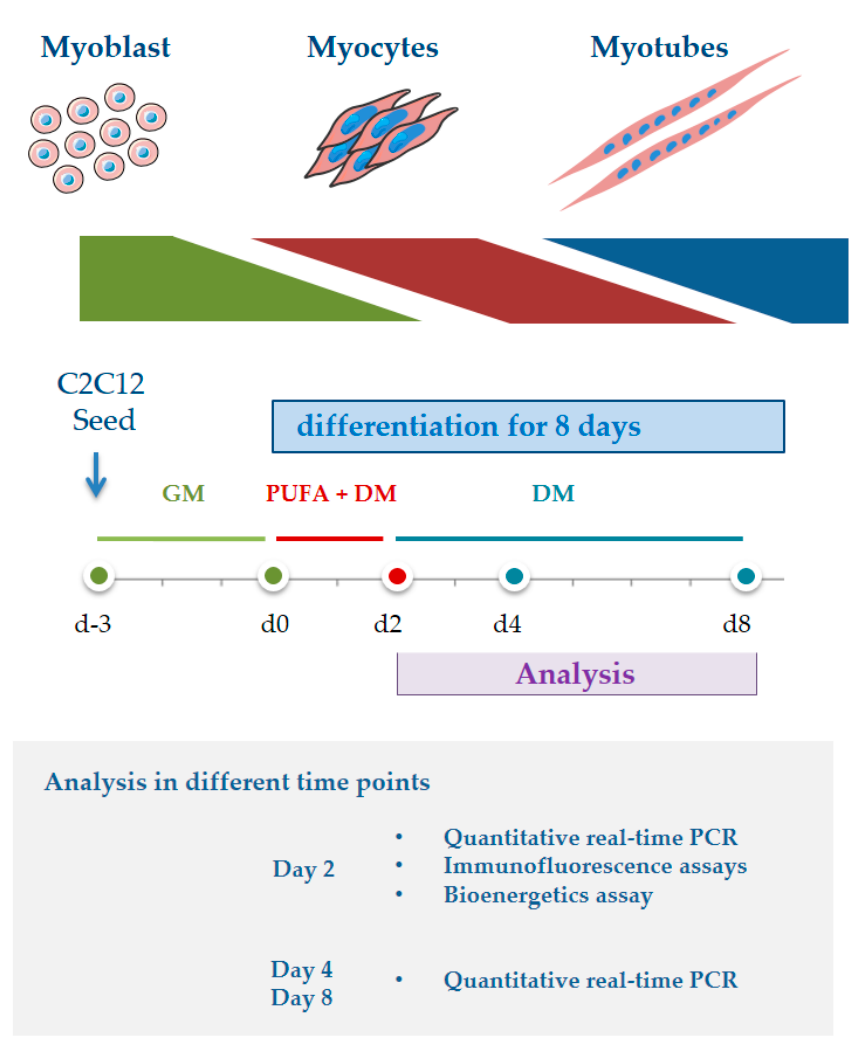
Figure 1. Summary of the experimental design of differentiation experiment. GM = growth medium; DM = differentiation medium.